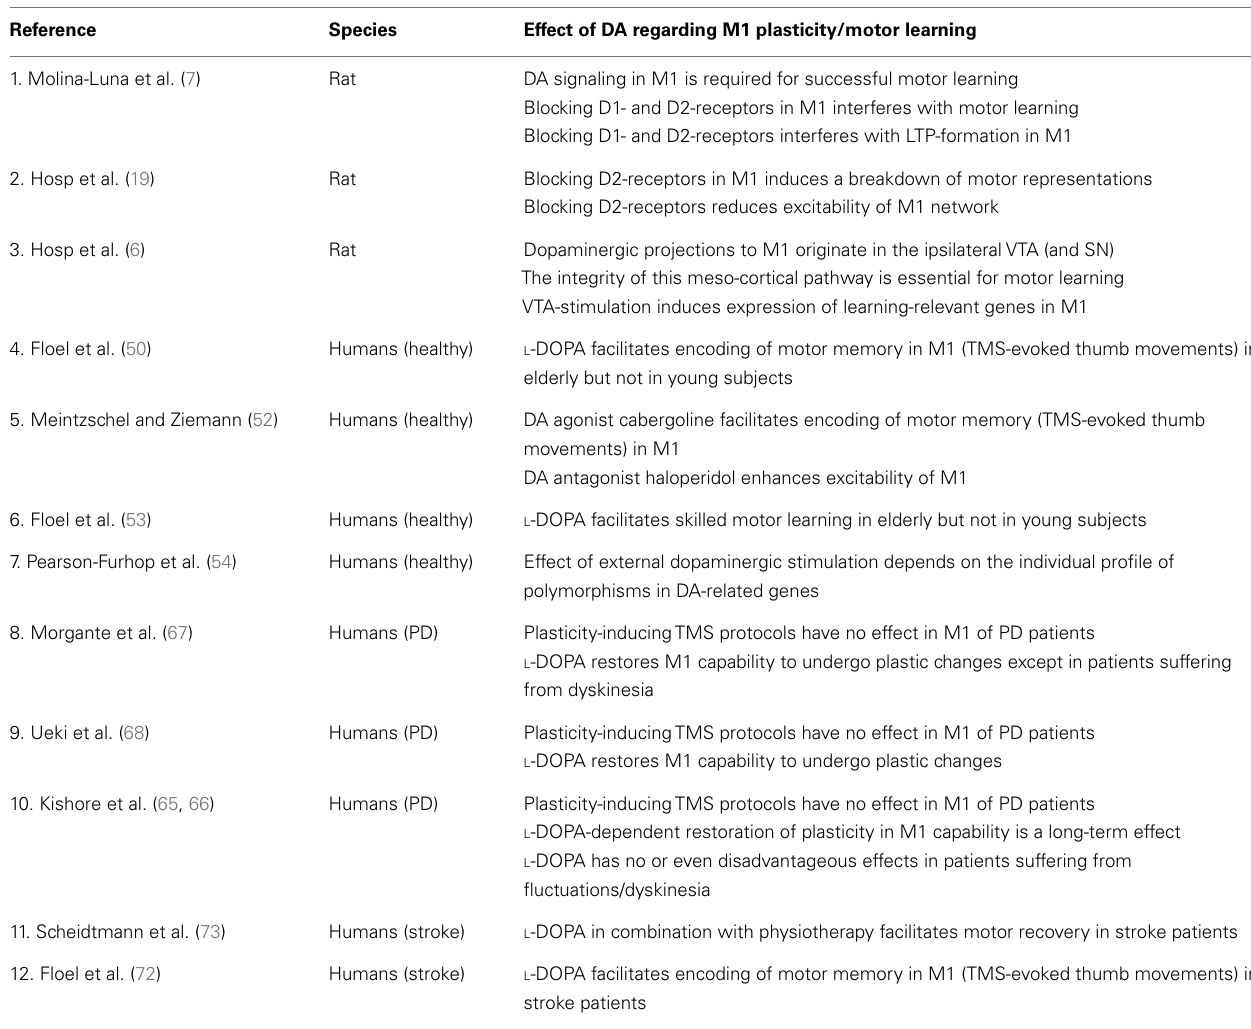
Table 1 | Collection of key papers studying the effect of dopaminergic signaling on plasticity in M1 and/or motor learning.